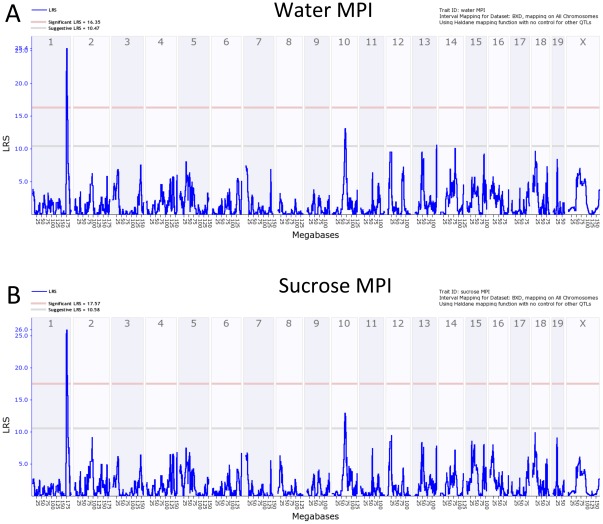
Genome-wide linkage maps of MPI.A. Water MPI. B. Sucrose MPI. Blue trace denotes likelihood ratio (LRS) statistic. A QTL on chromosome 1 exceeds the significance threshold (pink horizontal line; p<0.05) for either stimulus. A suggestive QTL (gray line; p<0.63) was found on chromosome 10.